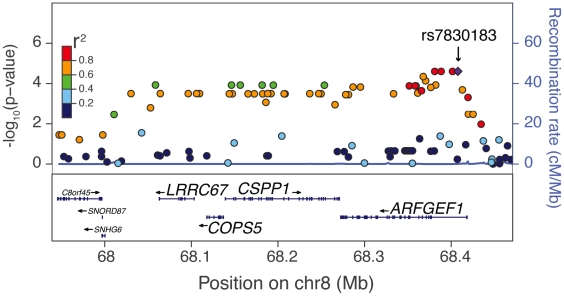
Chromosome 8 cluster of linked genes associated with cisplatin IC50 in ASW and YRI.The four genes associated with cisplatin IC50 were detected using a gene-based analysis [35]. They are COPS5 (ASW p = 1.8×10−4, YRI p = 0.020), ARFGEF1 (ASW p = 8.6×10−5, YRI p = 0.017), CSPP1 (ASW p = 2.4×10−4, YRI p = 0.017), and LRRC67 (ASW p = 3.1×10−4, YRI p = 0.020). Plots were made with LocusZoom [67] and the position of each dot corresponds to the SNP's p-value for association with carboplatin IC50 in the ASW and the color of each dot represents the SNP's linkage disequilibrium r2 in the YRI with the labeled SNP (purple diamond).